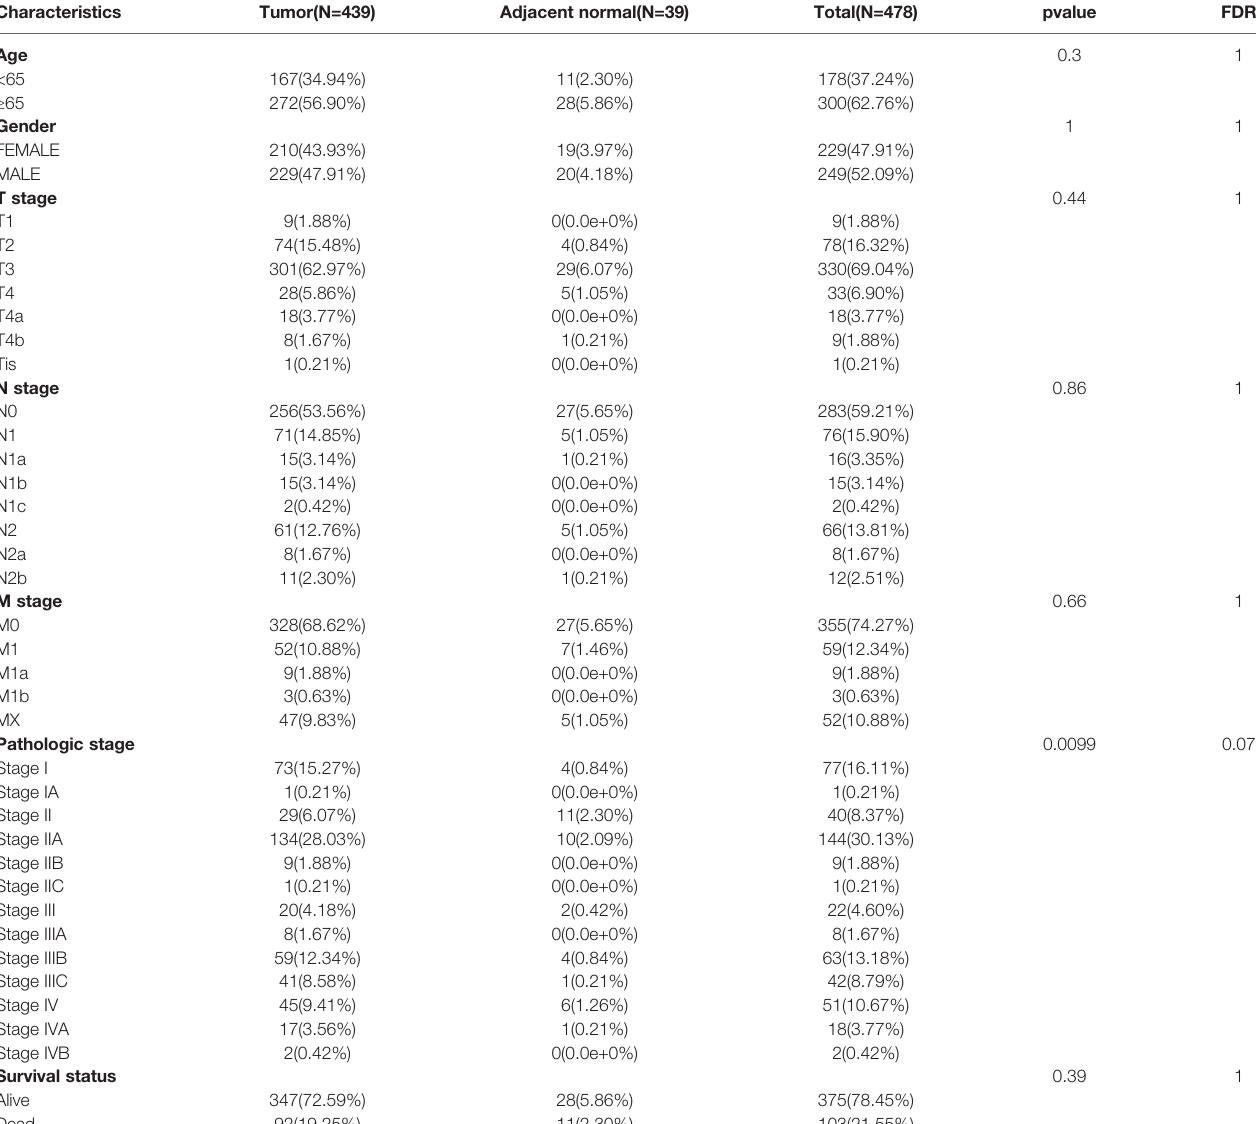
TABLE 1 | Characteristics of TCGA-COAD